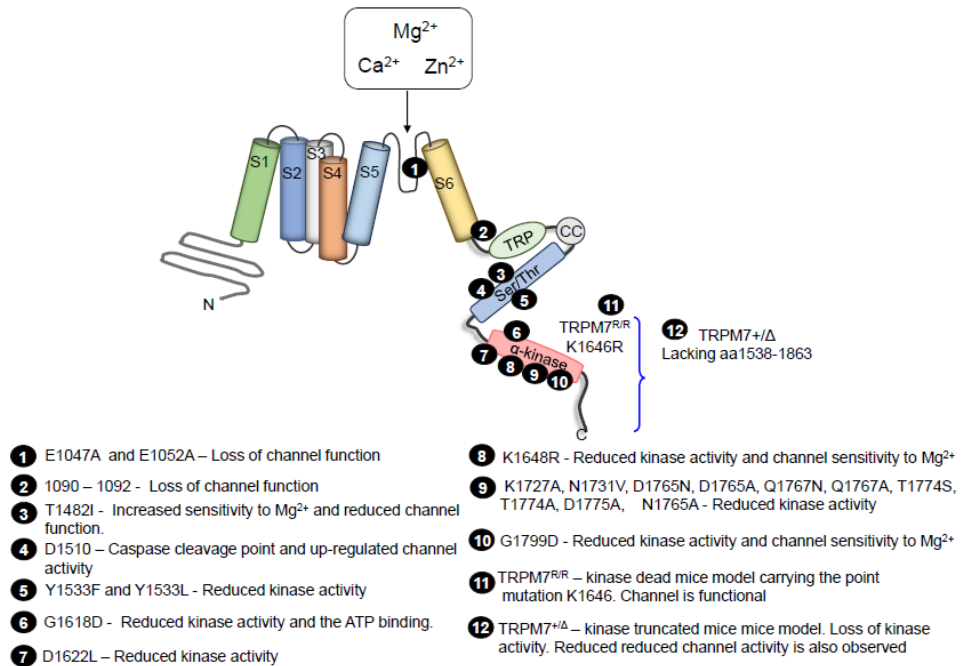
Figure 2. Schematic overview of TRPM7 mutations. Mutations that have been identified are highlighted. Numbers indicate the single amino acids or regions that affect TRPM7 channel or kinase activity [17,19,46,48,49,54 – 59].